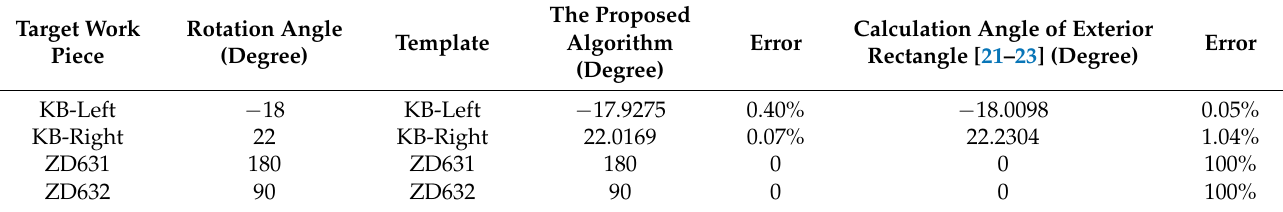
Table 2. Target workpiece phase difference